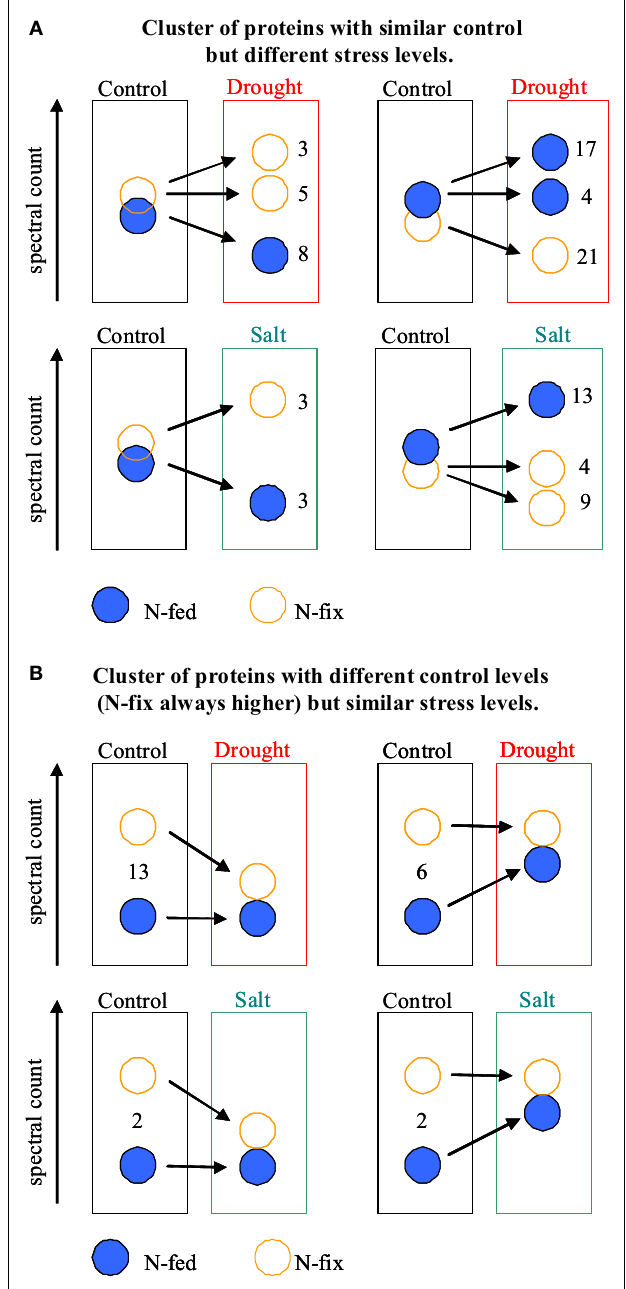
FIGURE 4 | Schematic overview of differentially up or down-regulated protein clusters depending on control level and nutritional status. (A) Similar control levels but different stress levels. (B) Different control levels but similar stress response levels. N-fed, nitrogen fertilization; N-fix, nitrogen